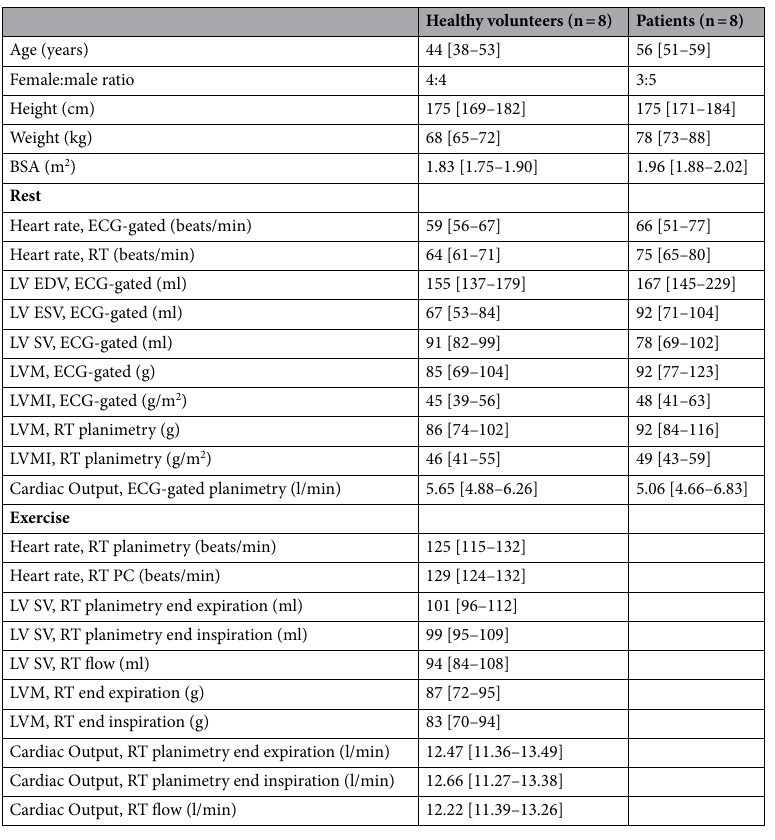
Table 1. Participant characteristics. Cardiac volumes and mass at rest were determined from bSSFP cine imaging. Values presented as median [IQR]. bSSFP balanced steady state free precession, BSA body surface area, ECG electrocardiogram, RT real-time, LV left ventricle, EDV end diastolic volume, ESV end systolic volume, SV stroke volume, LVM left ventricular mass, LVMI left ventricular mass index, PC